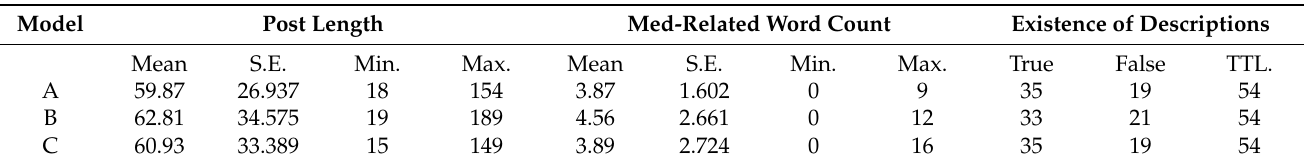
Table 1. Descriptive statistics of three main measurements among models. (Note. “A” denotes word embedding model, “B” denotes semantic model, and “C” denotes baseline model.). Model Post Length Med-Related Word Count Existence of Descriptions